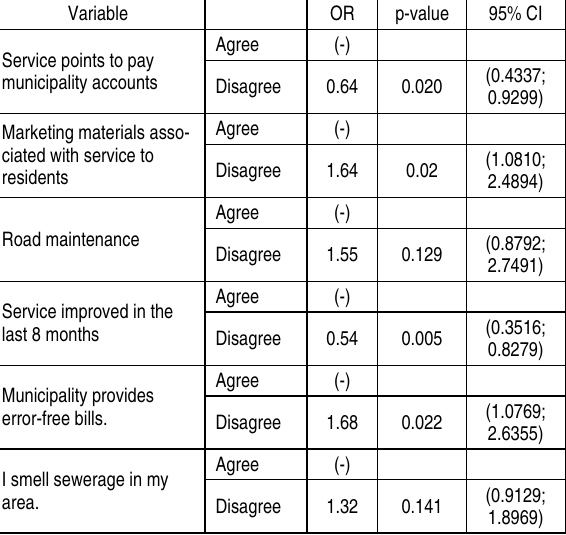
Table 3. Results from the multivariate logistic